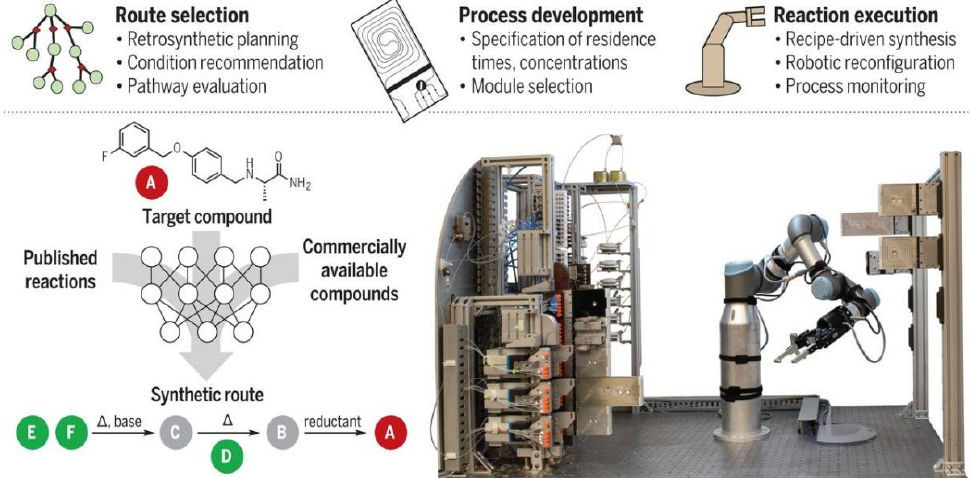
Figure 13. Automated synthesis system from design to synthesis. Reprinted with permission from ref. [60]. Copyright 2022, The American Association for the Advancement of Science.